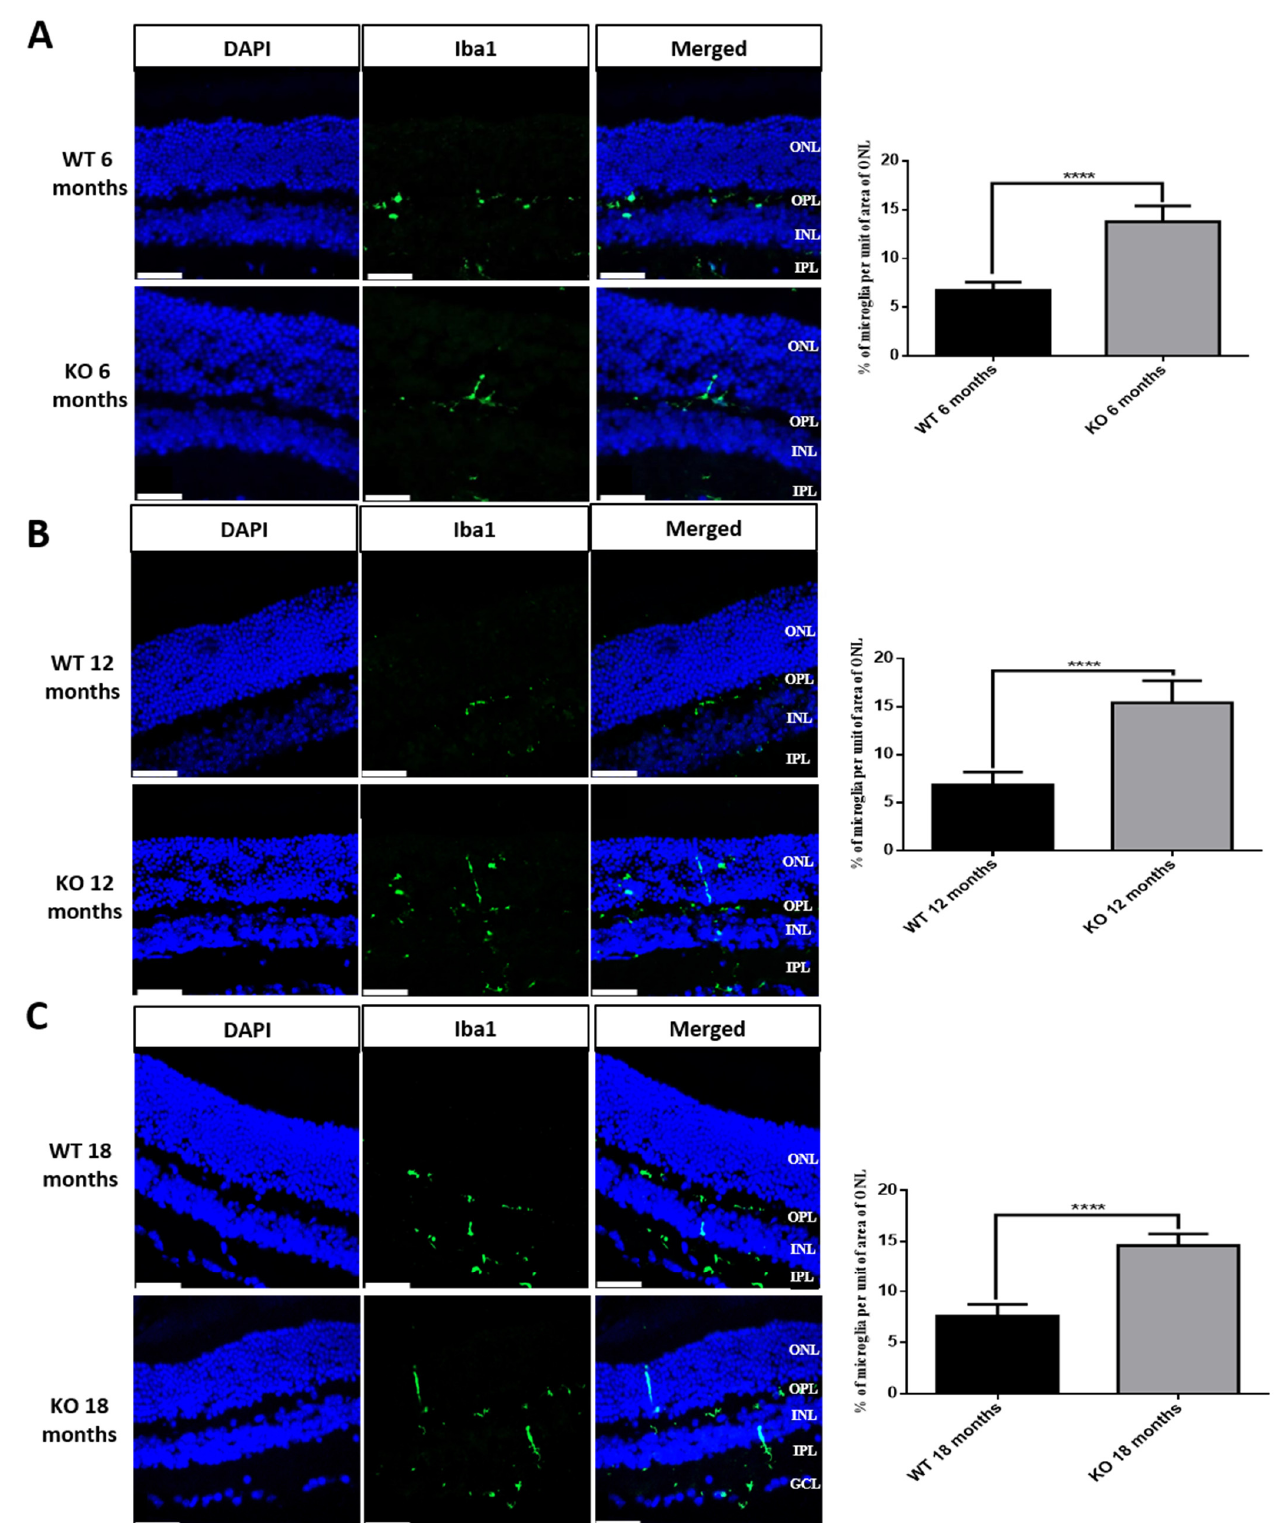
Figure 7. Microglia in the retinas of wiltype and Tspo KO mice at the ages of 6 ( A ), 12 ( B ) and 18 ( C ) months. Immunostaining of microglia marker: Iba-1 (green), was performed with cryosections from wildtype and Tspo KO mouse eyes. The intensity of microglia in the outer nuclear layer was quantified. Data were analyzed by t -test followed by Bonferroni test ( n = 5). INL: inner nuclear layer; IPL: inner plexiform layer; ONH: optic nerve head; ONL: outer nuclear layer; OPL: outer plexiform layer; RPE: retinal pigment epithelial cells. **** p < 0.0001. Scale bar, 10 µm.